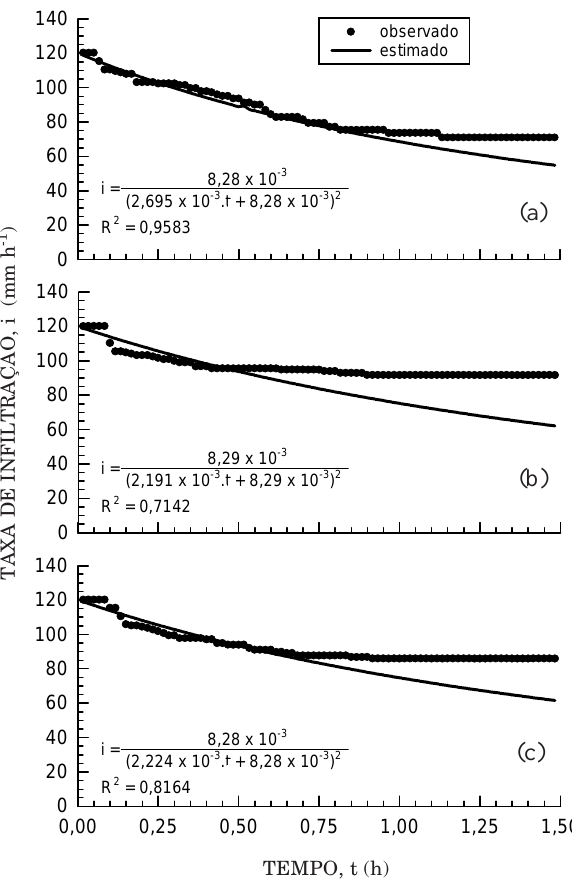
Figura 2. Taxa de infiltração observada e estimada durante os 90 minutos de chuva simulada para o preparo convencional (a), cultivo mínimo (b) e sistema plantio direto (c), após a colheita da cultura do milho